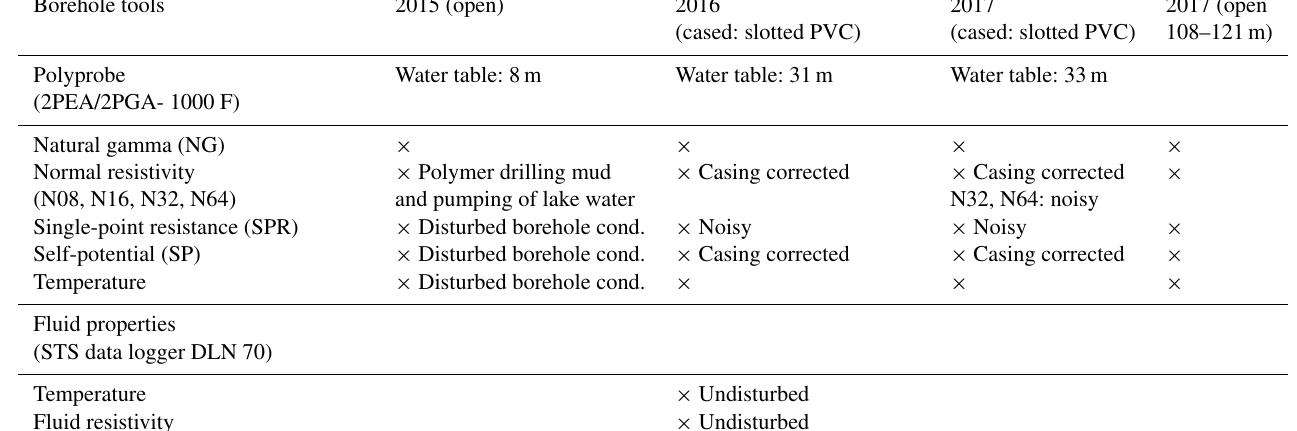
Table 1. List of borehole measurements performed in 2015, 2016, and 2017. Borehole tools